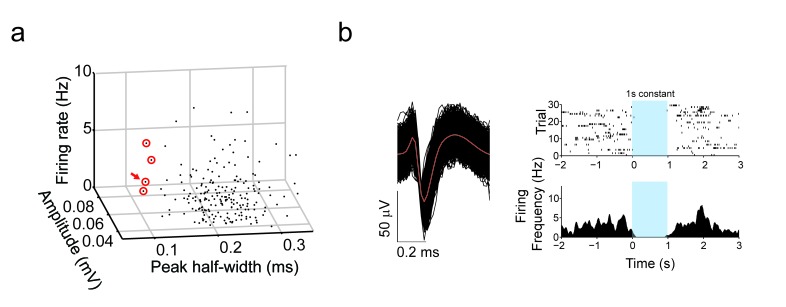
TRN terminal stimulation inhibits putative striatal fast-spiking (PV) interneurons.(a) 3D plot of all recorded units by peak half-width (ms), amplitude (mV) and firing rate (Hz). Putative PV interneurons sorted by narrow half widths (<0.12 ms). Red circles denotes putative fast spiking interneurons. Red arrow denotes putative fast spiking interneuron in shown in (b). (b) Example of (left) narrow spike waveform of putative fast-spiking (PV) interneurons from in vivo recordings in dorsal striatum of PV-Cre mice (n = 4). Red line denotes average superimposed on individual trials (black). (right, top) Individual trials raster plot of spiking with 1 s constant laser stimulation of TRN terminals in striatum. Blue window represents stimulation period. (right, bottom) Perievent time histograms of spiking (PETH) with 1 s constant laser stimulation of TRN terminals in striatum.